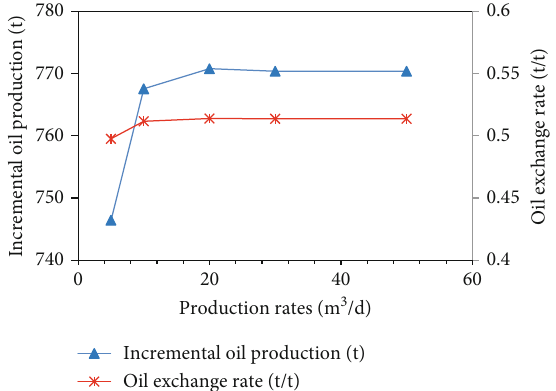
Figure 18: Incremental oil production and oil exchange rate through CO hu ff -n-pu ff under di ff erent production 2